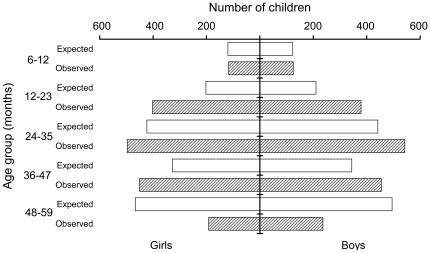
The observed and expected numbers of children (n  =  3,555) by age group and sex.